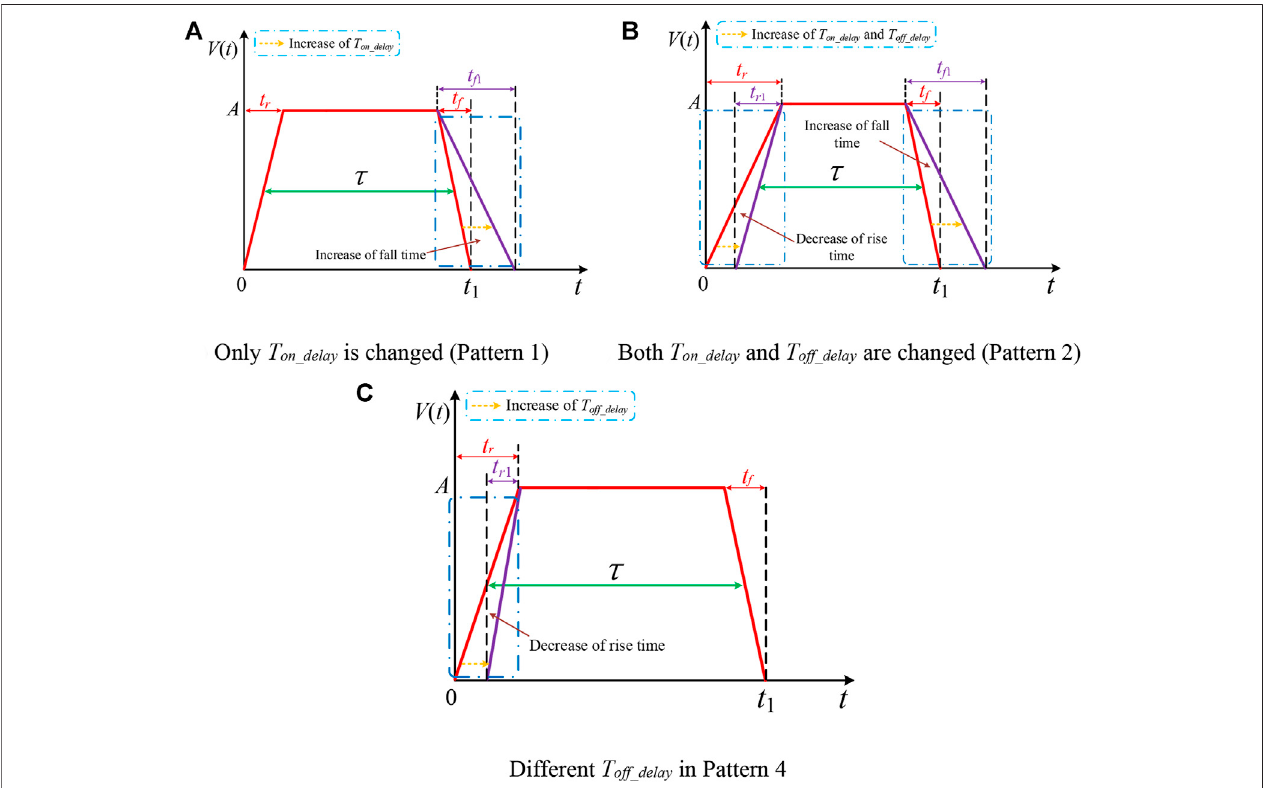
FIGURE4| CMvoltage waveformsoftheSi/SiChybridswitch. (A) Only Ton_delay ischanged (pattern1), (B) both Ton_delay and Toff_delay arechanged(pattern 2), and (C) different Toff_delay in pattern 4.